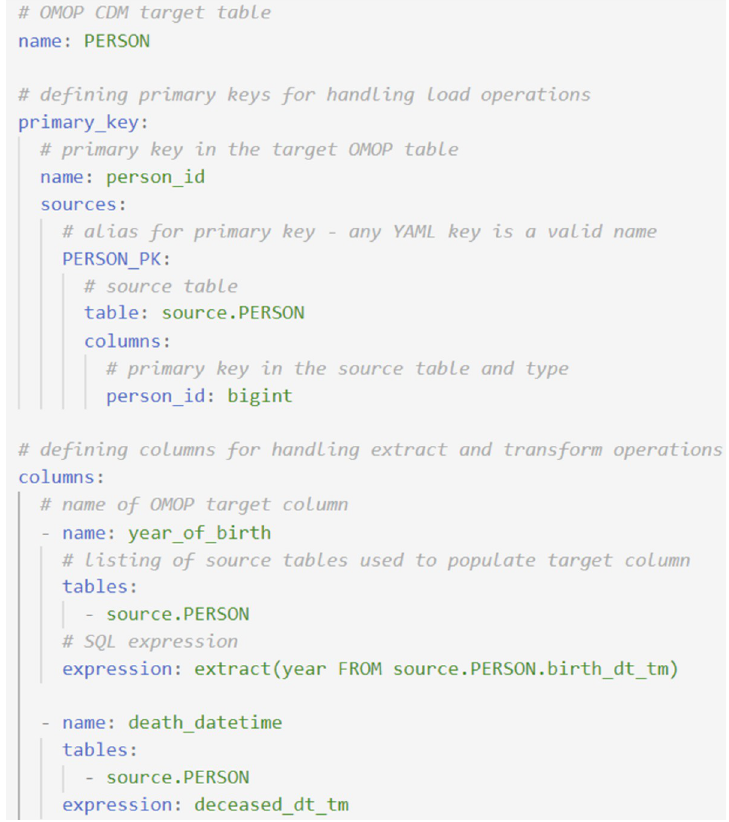
Fig 2. Source to OMOP YAML file structure. Rules for mapping from the CERNER PERSON table to the OMOP PERSON table, with rules defined for two columns of the OMOP PERSON table: year_of_birth and death_datetime. For each target table, the mapping rules are defined on a column-by-column basis using SQL snippets organized into YAML fields. Mapping a table requires three sections: (1) name of the OMOP table being mapped, (2) definition of primary keys used by the ETL framework to manage the load (insert) operations, and (3) mapping rules for columns in the OMOP table.